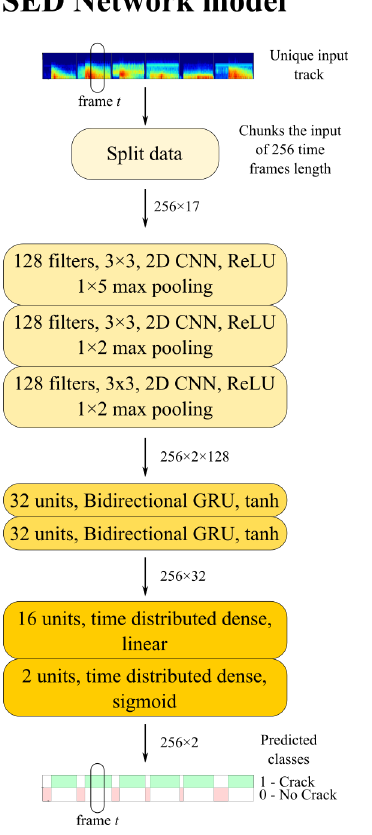
Figure 3. CRNN for